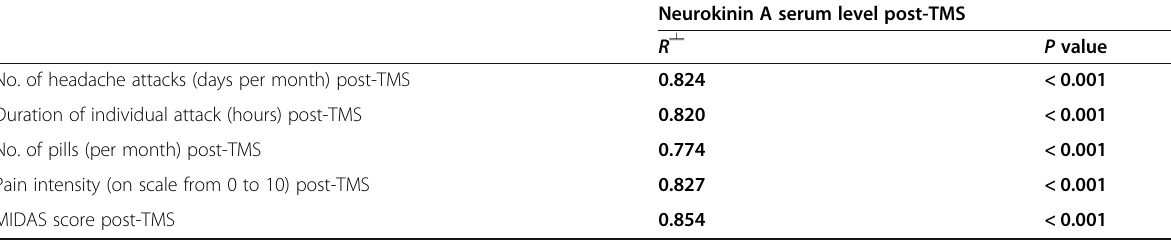
Table 6 Correlation between neurokinin A serum level and clinical parameters of migraine